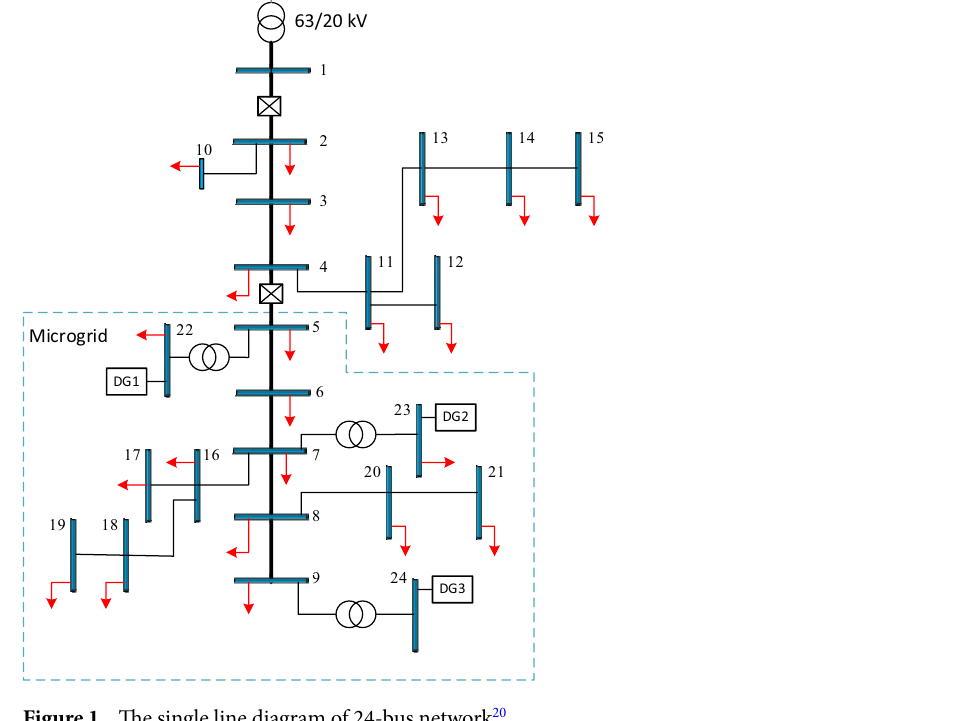
Figure 1. The single line diagram of 24-bus network 20